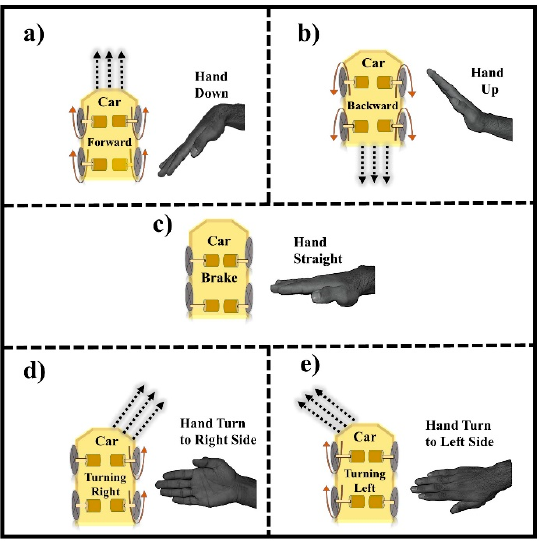
Figure 3. The theme of gesture recognition (i.e., movement of hand, motors, and wheels): ( a ) Hand Down; ( b ) Hand Up; ( c ) Hand Straight; ( d ) Hand Turn to Right Side; ( e ) Hand Turn to Left